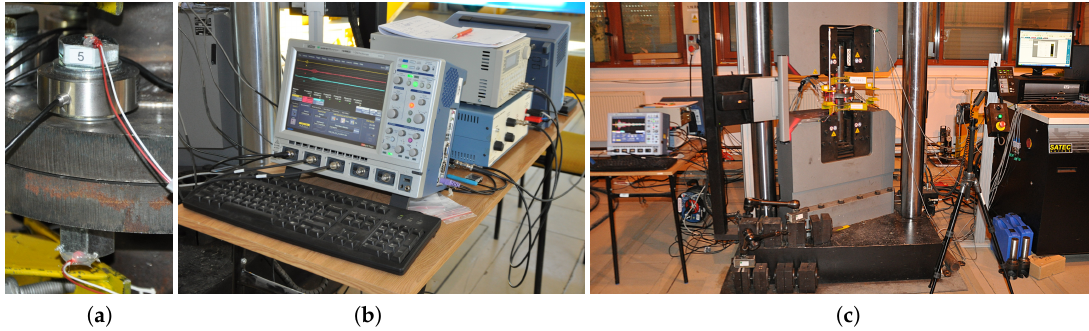
Figure 3. Laboratory setup: ( a ) Piezoelectric transducers mounted at the bolt ends (a washer-type force sensor is also visible in this case). ( b ) Digital oscilloscopes, function generator, and amplifier. ( c ) Static test machine Instron J1D 1200 kN.